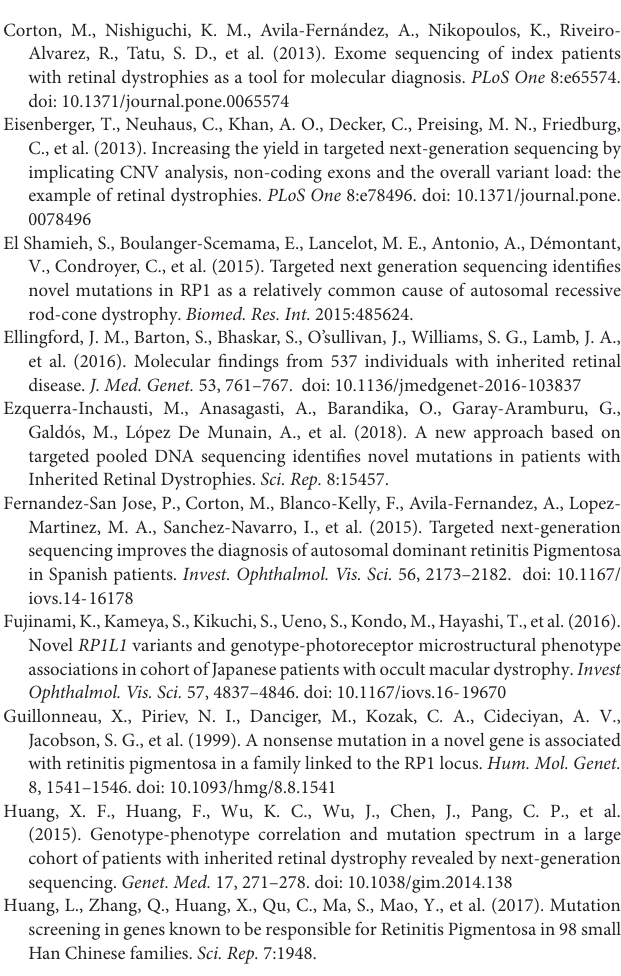
Supplementary Figure 1 | Pedigrees and Sanger sequencing chromatography of unrelated families with identified RP1 variants in this study. For each family, the pedigree is shown in the left column and the sequence changes are shown in the right column. Mx, mutant allele; +, wild-type allele. Supplementary Figure 2 | The distributions and frequencies of the missense variants in RP1 . The positions and allele counts of the heterozygous RP1 variants are displayed above, while those of the biallelic RP1 variants are displayed below. RP, retinitis pigmentosa; CRD, cone-rod dystrophy; MD, macular degeneration;